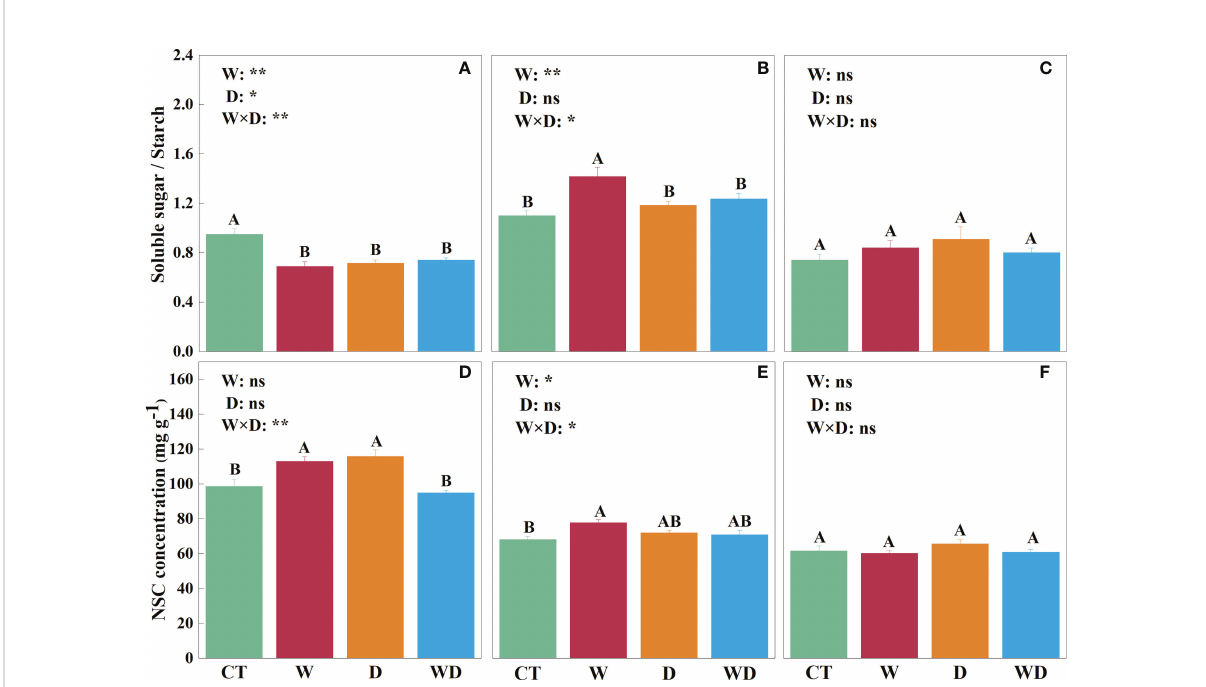
FIGURE 3 Effects of warming and drought on the ratios of soluble sugar to starch in the leaves (A) , roots (B) , and litter (C) and NSC concentrations in the leaves (D) , roots (E) , and litter (F) of C lanceolata . The bars with different letters were signi fi cantly different from each other ( p < 0.05). Treatments: control (CT), warming (W), drought (D), and warming plus drought (WD). Values were mean ± SE ( n = 5); treatment in the combination was expressed as W, warming effect; D, drought effect; and W×D, interactive effect of warming and drought; *, signi fi cant effect at